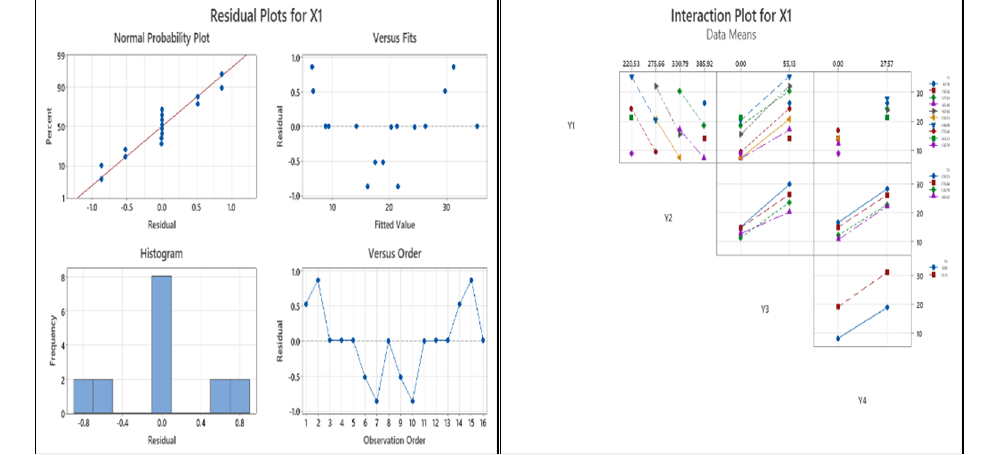
Figure 8. Residual plots and interaction plots from the general linear model for X1 (compressive strength).